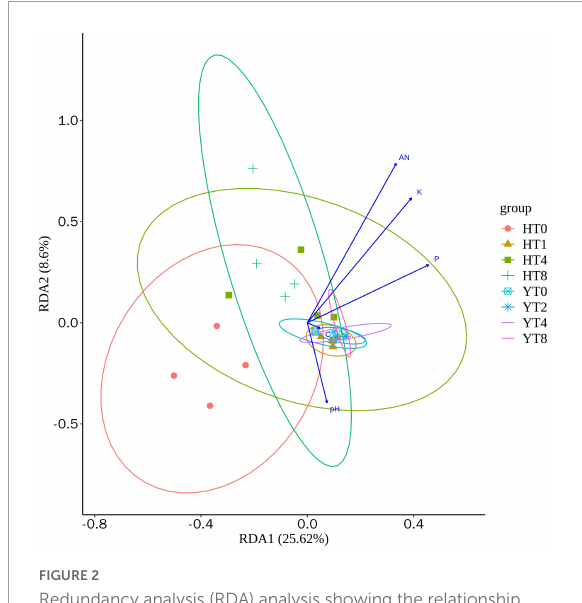
FIGURE2 Redundancy analysis (RDA) analysis showing the relationship between environmental factors (AN: alkaline hydrolyzed nitrogen; P: phosphorus; K: potassium; C: carbon; and pH) and fungal communities of both varieties Honghua Dajinyuan (H) and Yunyan 87